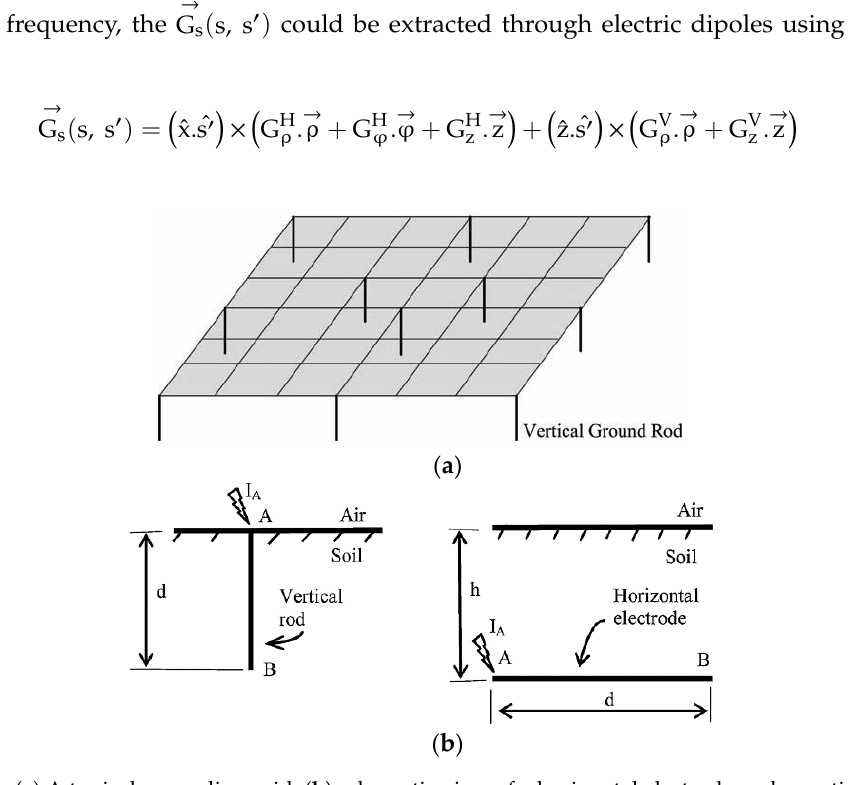
Figure 1. ( a ) A typical grounding grid, ( b ) schematic view of a horizontal electrode and a vertical rod. ( ϑ ) flowing in nth section of the grounding grid, can be approximated The unknown current I e n